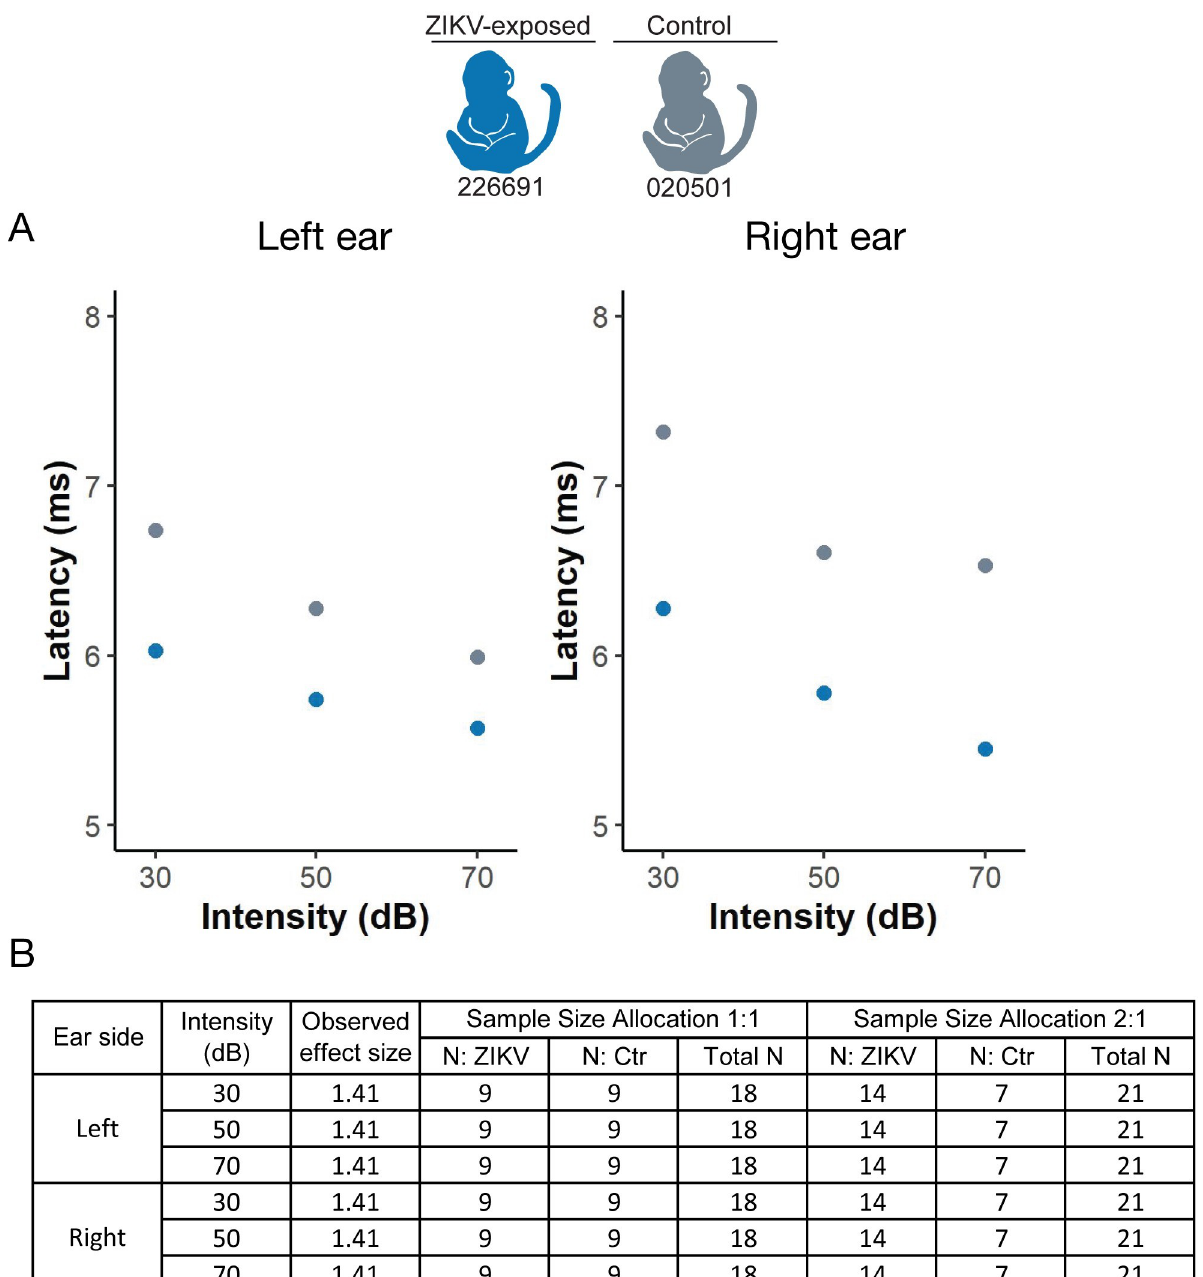
Fig 10. Hearing measured by auditory brainstem response testing. (A) Auditory brainstem response testing Wave IV thresholds to click stimuli. (B) Effect sizes and sample size requirements for detecting the observed effect sizes with 80% power at the two-sided 0.05 significance level, assuming a sample size allocation of 1:1 and 1:2 ZIKV to control